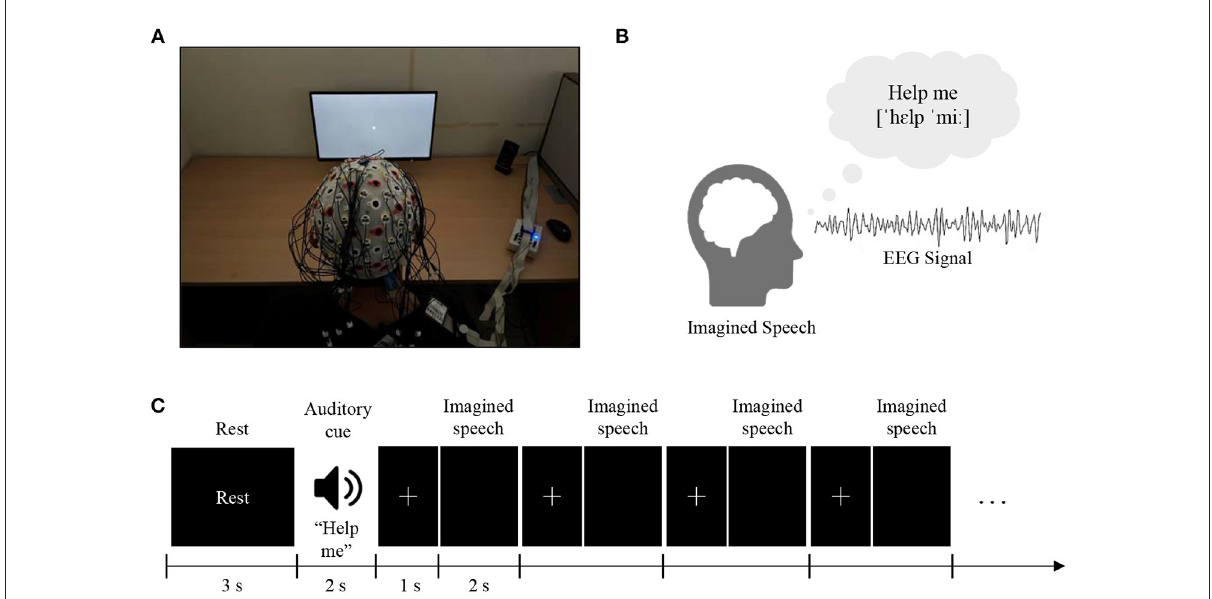
FIGURE7 Experimental setups and protocols. (A) The subjects were seated in a comfortable chair in front of a 24-inch LCD monitor screen and were instructed to imagine the silent pronunciation of the given word as if they were performing real speech, without moving any articulators or making the sound. (B) Five critical main words/phrases for basic communication (“hello,” “help me,” “stop,” “thank you,” and “yes”) were selected. Seventy trials per class (70 × 5 = 350 trials) are released for training (60 trials per class) and validation (10 trials per class) purposes. (C) An auditory cue was randomly presented for 2 s, followed by 0.8–1.2 s of a cross mark. The subjects were instructed to perform imagined speech of the given cue as soon as the cross mark disappeared on the screen. Four cross marks and imagined speech phases were followed in a row per random cue. After performing the imagined speech four times, 3 s of the relaxation phase was given to clear the